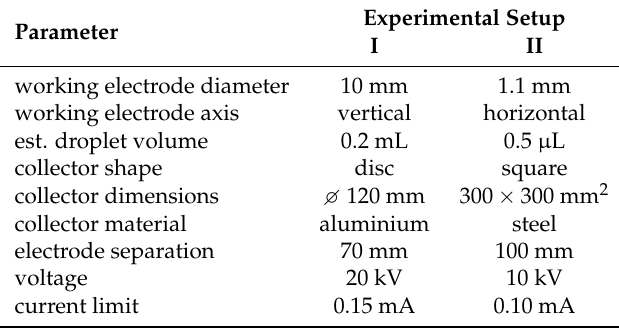
Table 1. Technical parameters of experimental measurements.